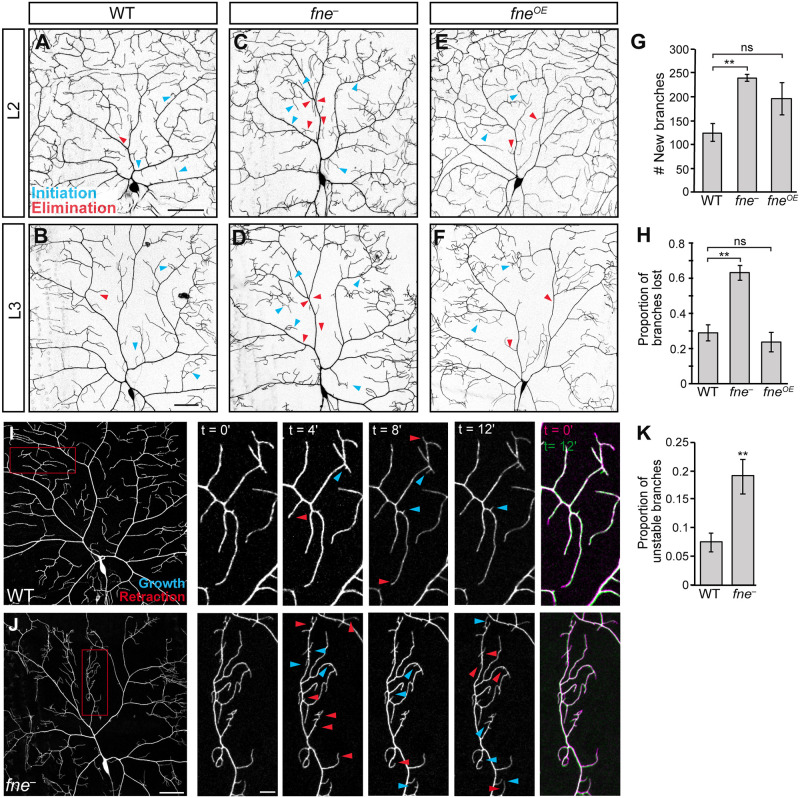
Fne is required for branch stability.(A-F) Confocal z-series projections of wild-type (WT; A, B), fne−(C, D) and fneOE (E, F) neurons imaged at L2 (A-C) and then again at L3 (D-F). For fneOE, ppk-GAL4 was used to drive expression of UAS-fne. For all genotypes, ppk-GAL4 was used to express UAS-CD4-tdGFP to mark the neurons. Arrowheads indicate new branches (blue) and lost branches (red) between L2 and L3. (G) Quantification of the number of new branches between L2 and L3 for WT (n = 6 neurons), fne−(n = 5 neurons), and fneOE (n = 5 neurons). Values are mean ± s.e.m.; **p<0.01 compared to WT as determined by one-way ANOVA with Bonferroni-Holm post hoc test. (H) Quantification of the proportion of branches lost between L2 and L3 for neurons in (G). Values are mean ± s.e.m.; **p<0.01 compared to wild-type as determined by one-way ANOVA with Bonferroni-Holm post hoc test. (I, J) Time-lapse confocal z-series projections of WT (I) and fne−(J) class IV da neurons at late L3. Arrowheads indicate new/growing (blue) and lost/retracting (red) branches. (K) Proportion of branches undergoing initiation, elimination, growth or retraction events for WT (n = 4 neurons) and fne−(n = 3 neurons). Values are mean ± s.e.m.; **p<0.01 as determined by two-tailed Student’s t-test; ns = not significant. Scale bars: 50 μm, 10 μm in enlargements.